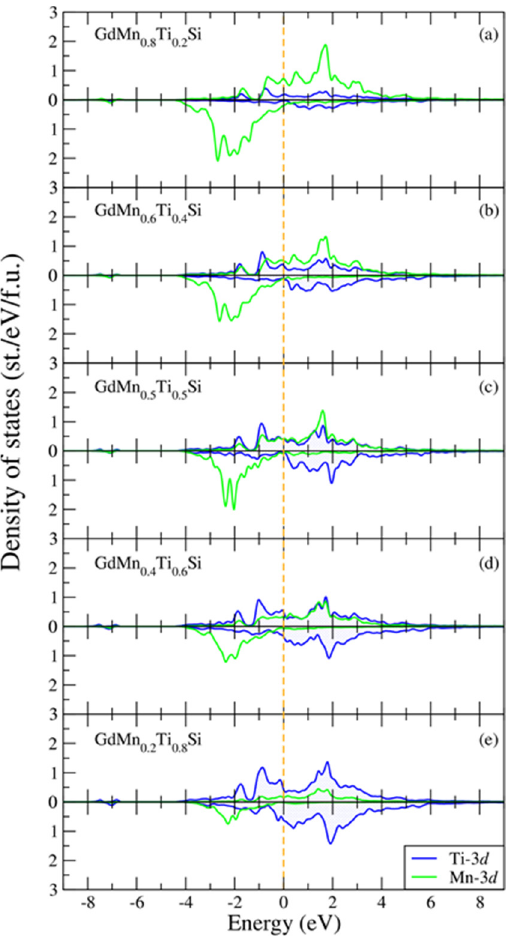
Figure 7. The partial densities of the 3d states of Mn and Ti per formula unit in the following compounds: ( a ) GdMn 0.8 Ti 0.2 Si; ( b ) GdMn 0.6 Ti 0.4 Si; ( c ) GdMn 0.5 Ti 0.5 Si; ( d ) GdMn 0.4 Ti 0.6 Si; ( e ) GdMn 0.2 Ti 0.8 Si. The Fermi level is a dashed vertical line.